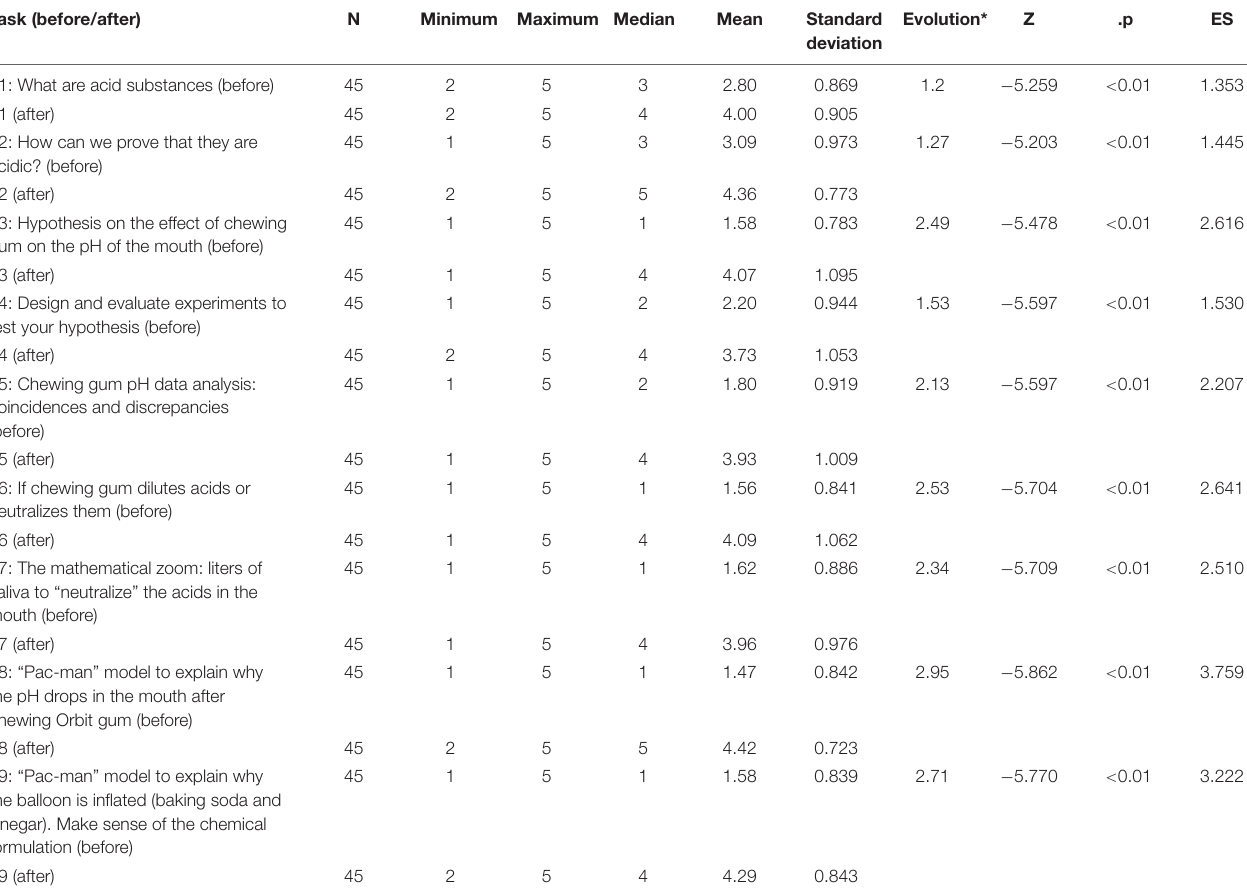
TABLE 1 | Knowledge declared by the participants for the 9 tasks, before and after carrying them out. Task (before/after) N Minimum Maximum Median Mean Standard